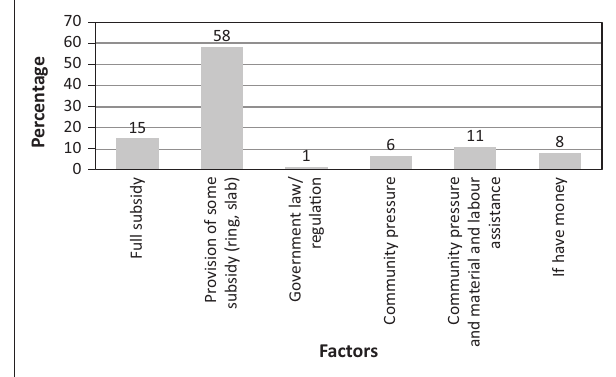
FIGURE 10: Who decides to build a latrine? FIGURE 12: Required characteristics of a latrine.